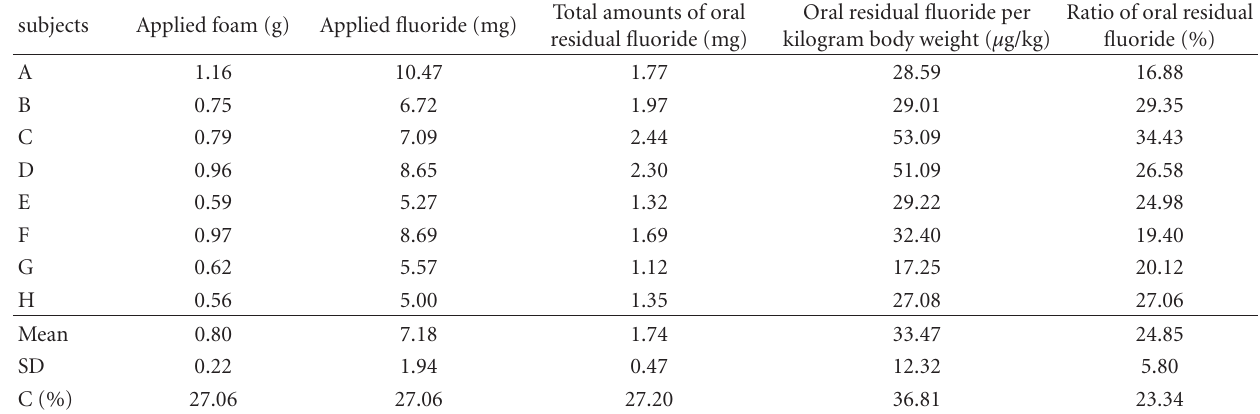
Table 4: The oral residual fluoride following the application of sodium fluoride foam.